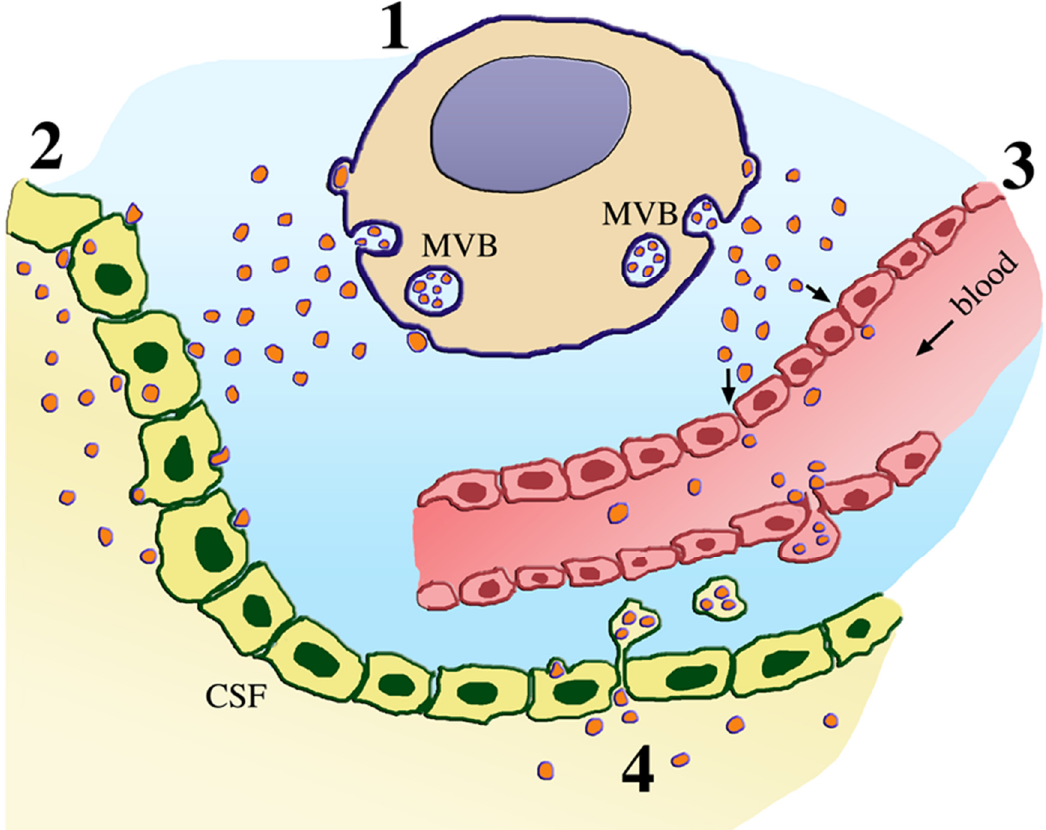
Figure 1. Traffic of extracellular vesicles (EVs) released by a neural cell. The neural cell at the top (cytoplasm of grain color, marked 1) releases the two types of EVs, the small exosomes by exocytosis of multivesicular bodies (MVB), and the larger ectosomes by shedding of plasma membrane rafts. Upon release, the vesicles navigate in the extracellular fluid (light blue). Their targeting relevant for fluid biomarker generation can be accumulate either to the central spinal fluid (CSF) of the ventricular system (left, peach color, marked 2) or as shown by the arrows to the blood (right, red-pink color, marked 3). Additional CSF-to-blood EV transfer occurs by large vacuoles operative at the arachnoid villi (bottom, marked 4). Thus, molecules and EVs can move from the extracellular space and the CSF to the blood plasma. In the case of neurodegenerative diseases, the molecules and EVs of such origin account for significant fractions of the total transferred to the fluids.